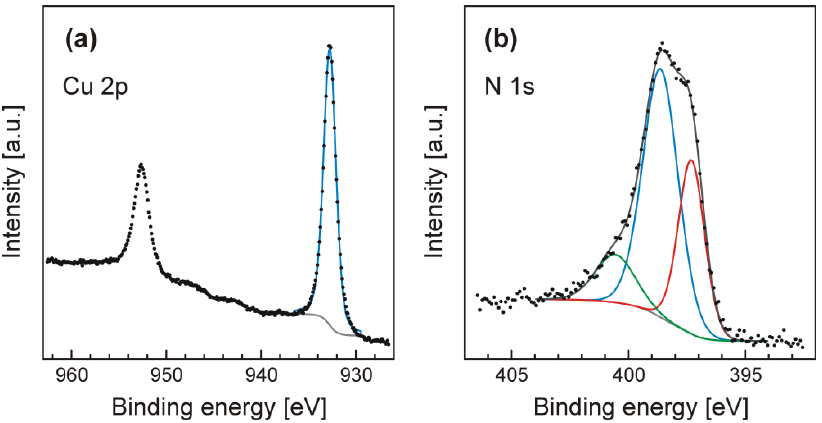
Figure 9. X-ray photoelectron spectroscopy (XPS) spectra: ( a ) Cu 2p core level, ( b ) N 1s level. The copper peaks shown in Figure 9a were detected at the energies of 932.7 eV (Cu 2p3/2) and 952.7 eV (Cu 2p1/2). Cu 2p3/2 level was easily fitted with a single